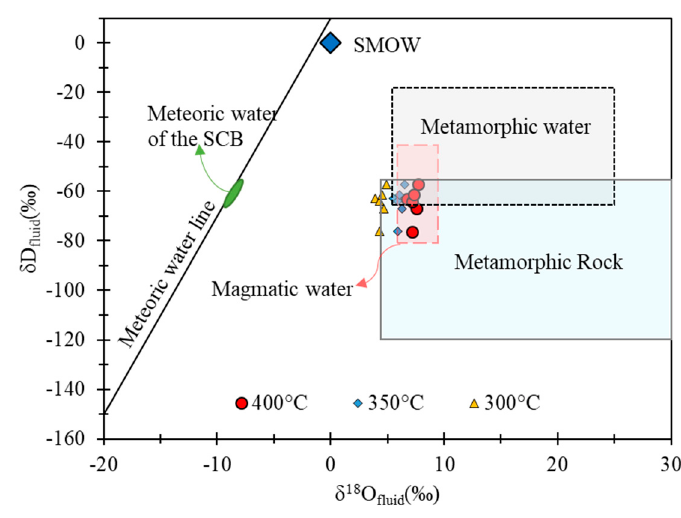
Figure 10. Hydrogen and oxygen isotope composition of quartz from the Shangfang W deposit. The range of Mesozoic meteoric water for the South China Block (SCB) is estimated according to previous works [43–45]. Furthermore, the H–O isotopic fields for ordinary metamorphic water is from Taylor [46] , for primary magmatic water is from Hedenquist et al . [47] , and for metamorphic rocks is from Hoefs et al . [48] .